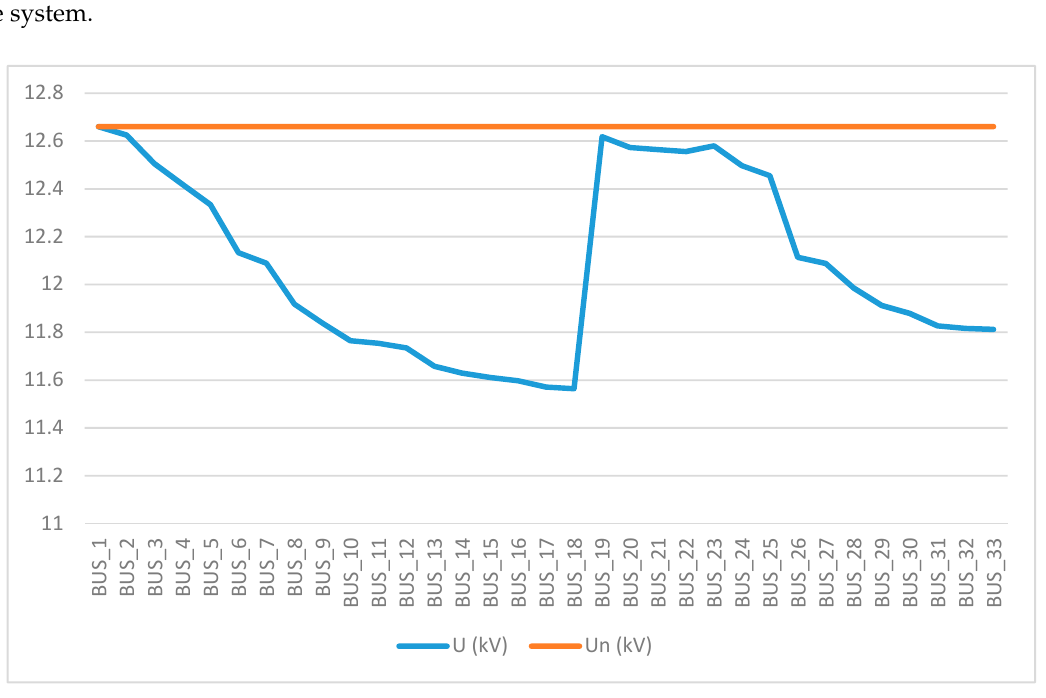
Figure 3. Base case voltage profiles of the IEEE 33-bus radial distribution system with no DG.